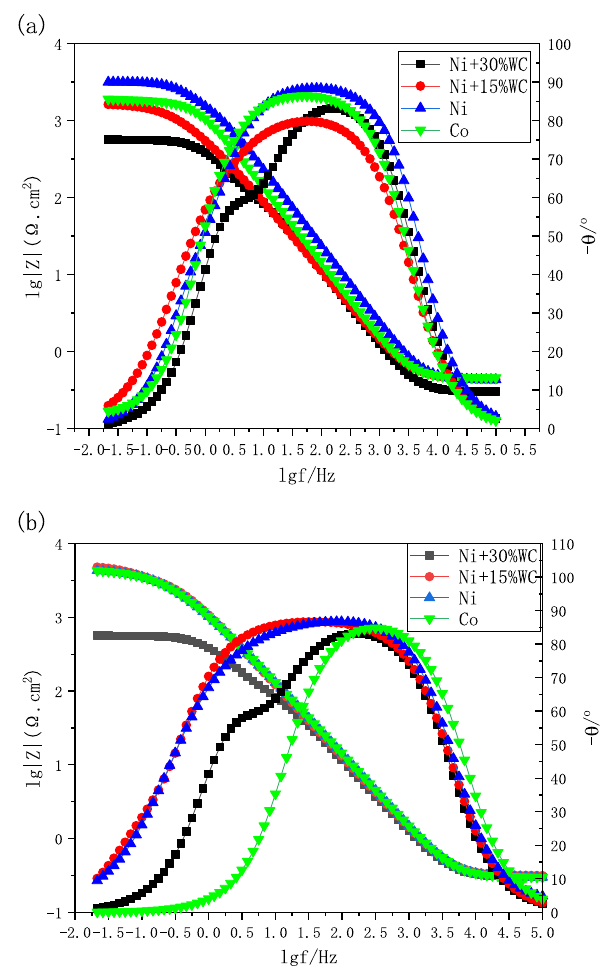
Figure 7: Bode impedance plots of di ff erent coatings in